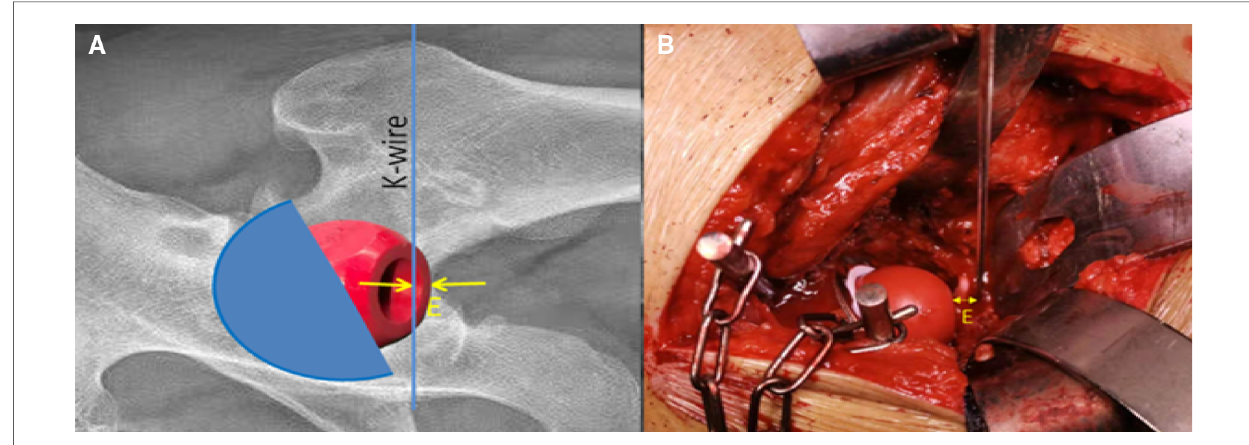
FIGURE 2 Intraoperative measurement of the height of the acetabular cup: A ’ : A ’ =r+E for the right picture, and A ’ =r − E for the left picture.